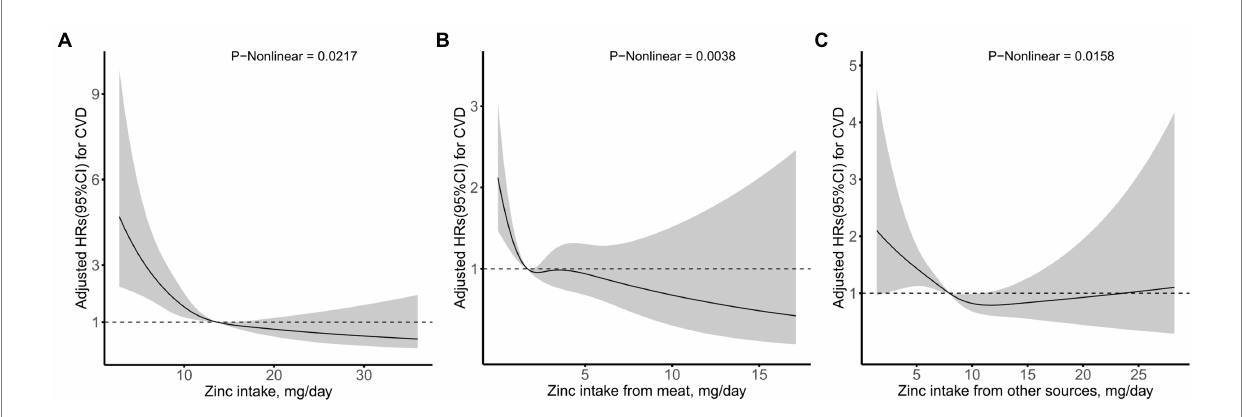
FIGURE 2 Relation of zinc intake from (A) total, (B) meat, and (C) other sources with risk of new-onset CVD*. *Adjusted for age, gender, race, energy intake, residence, marital status, education level, activity level, smoking status, drinking status, BMI, hypertension, diabetes, dietary fiber, niacin, vitamin C, vitamin E, calcium, iron, selenium, magnesium, copper, and